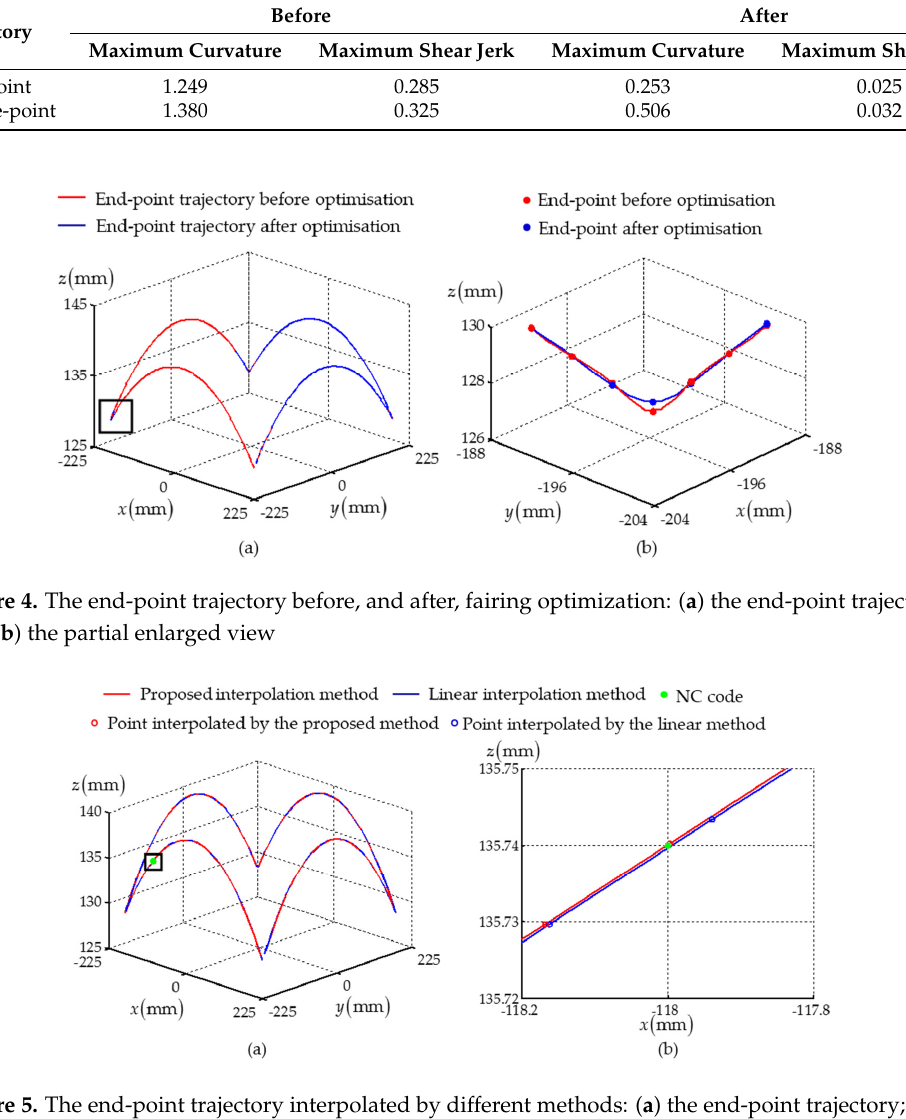
Figure 7. Runtime of the trajectory interpolated by the linear method: ( a ) runtime of the trajectory; and ( b ) the partial enlarged view.